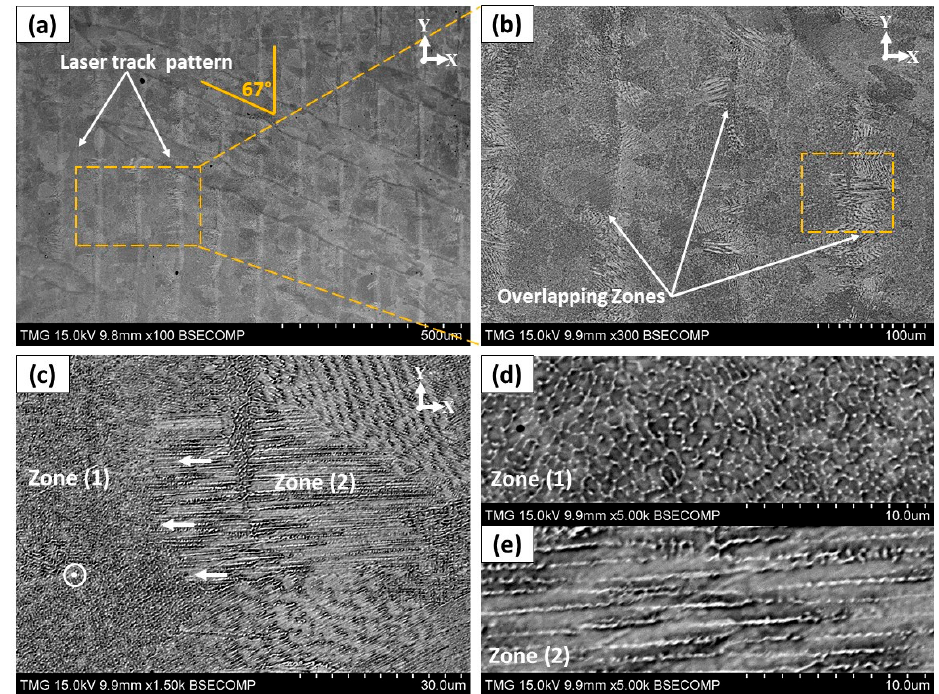
Figure 5. ( a ) Optical microscope (OM) micrograph of the vertical plane with arc ‐ shape melt pool boundaries; SEM micrograph of the etched as ‐ printed IN718 in the vertical plane showing: ( b ) columnar grains with epitaxial growth across several layers; ( c ) dendrite size at the melt pool boundaries; ( d ) changes in the dendrite direction in the overlapping zone. Arrows 1, 2 and 3 indicate the EDS spot analysis of grain boundaries Laves phase, inter ‐ dendritic Laves and γ‐ matrix, respectively, as listed in Table 3. Table 3. EDS spot analysis results of the as ‐ printed condition in Figure 5 (wt.%).